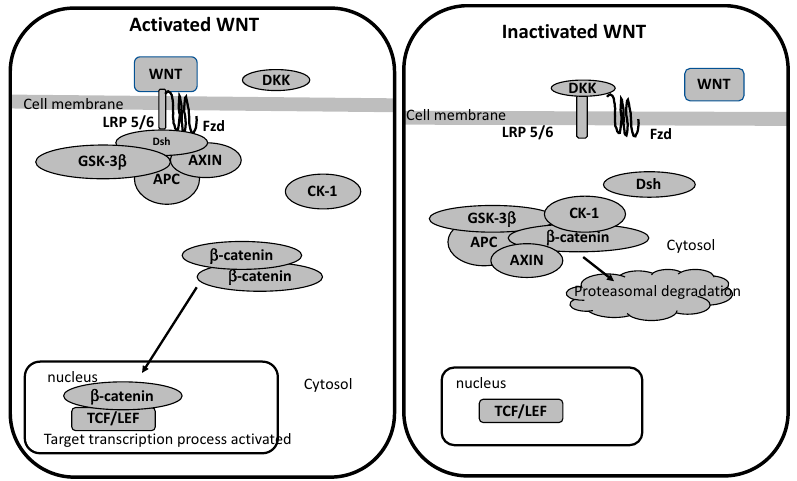
Figure 1. Activated and Inactivated WNT pathway. APC: adenomatous polyposis coli; CK-1: casein kinase 1; DKK: dickkopf-1; Dsh: disheveled; Fzd: frizzled; GSK-3 β : glycogen synthase kinase-3 β ; LRP 5/6: low-density lipoprotein receptor-related protein 5/6; TCF/LEF: T-cell factor/lymphoid enhancer factor; TNF- α : tumor necrosis factor alpha.